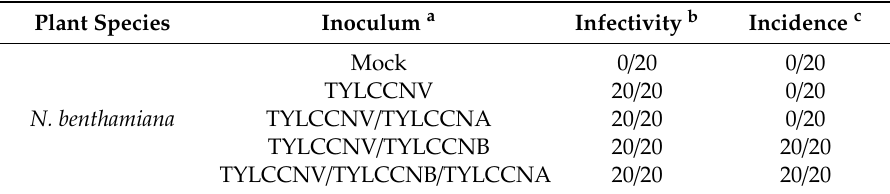
Table 1. Infectivity and incidence induced by TYLCCNV, TYLCCNV / TYLCCNA, TYLCCNV / TYLCCNB or TYLCCNV / TYLCCNB / TYLCCNA in N. benthamiana plants at 7